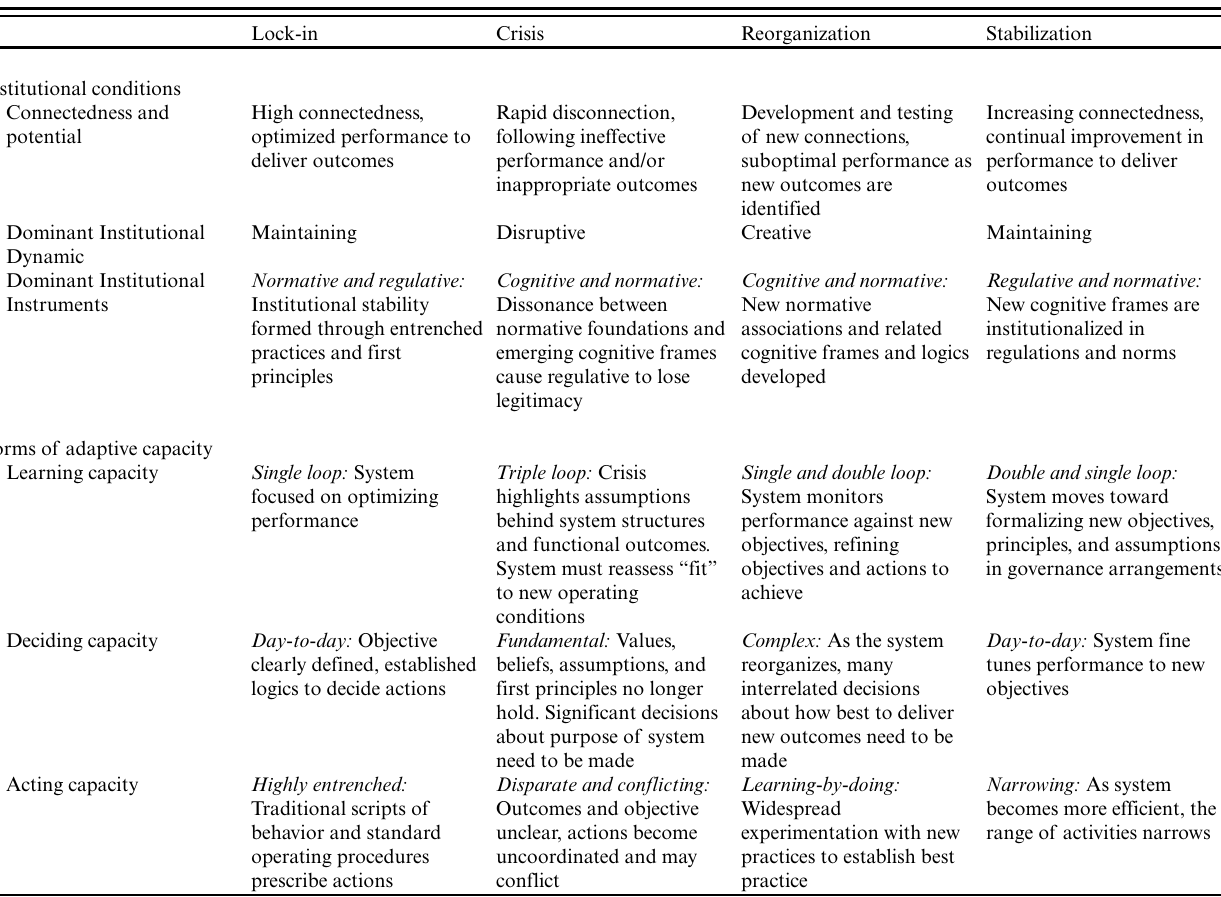
Table 3. Propositions for identifying adaptive capacity in